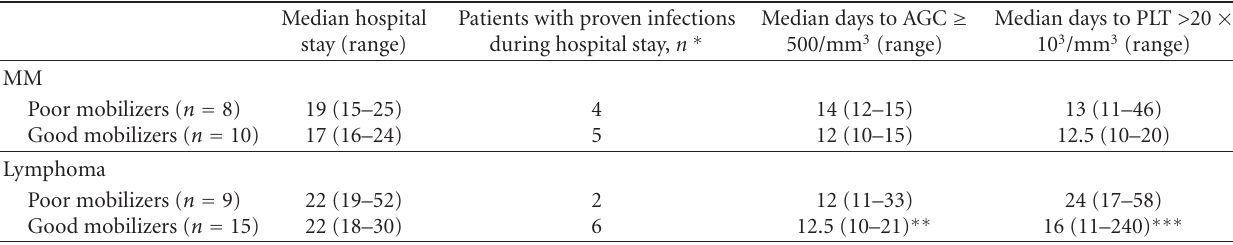
Table 6: Hospitalization course and engraftment: comparison between poor and good mobilizers. Median hospital Patients with proven infections stay (range)